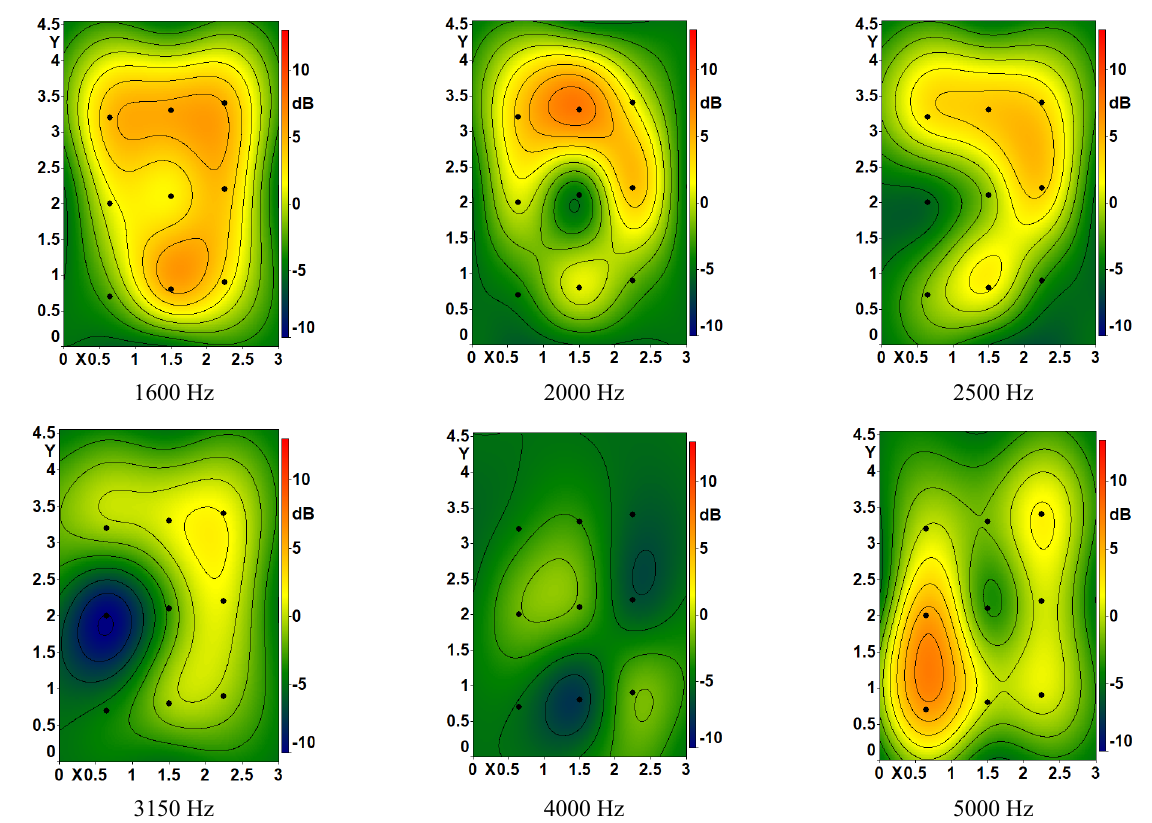
Figure A2. Air ‐ borne source radiation index maps. Average between the three source positions.